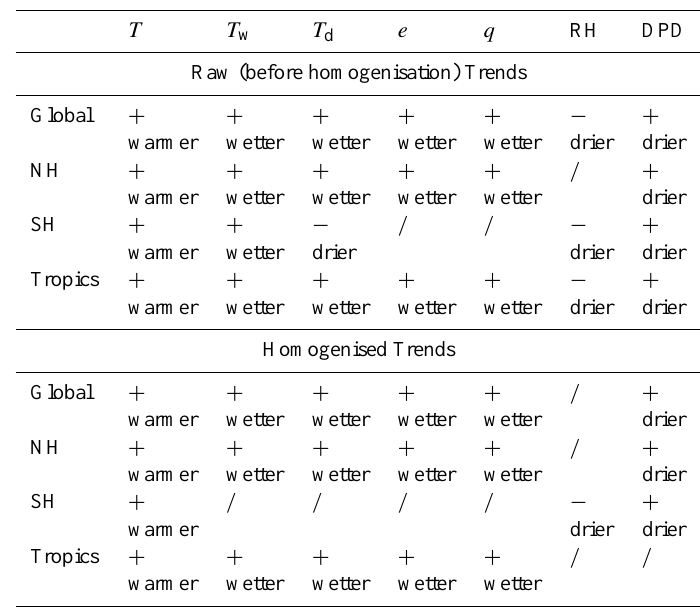
Figure 9. Comparison of decadal trends from 1973–2013 between raw and homogenised monthly mean specific humidity. (a) Ratio of raw to homogenised trends for each grid box (a value of > 1 means that the raw trend is greater than the homogenised trend). (b) Scatter plot of raw verses homogenised decadal trends for each grid box with percentage presence in each quadrant. (c) Trend size distribution for raw and homogenised grid boxes. (d) Large-scale area-average time series (weighted by the cosine of the latitude) and decadal trends calculated using the median of pairwise slopes with 5th to 95th percentile slopes as confidence intervals. Table 2. Regional trend direction summary before and after homogenisation. + significant increasing trend, − significant decreasing trend, / no significant trend. Boxes are labelled for warming (warmer), increasing water vapour/closeness to saturation (wetter), decreasing water vapour/closeness to saturation (drier) and no change